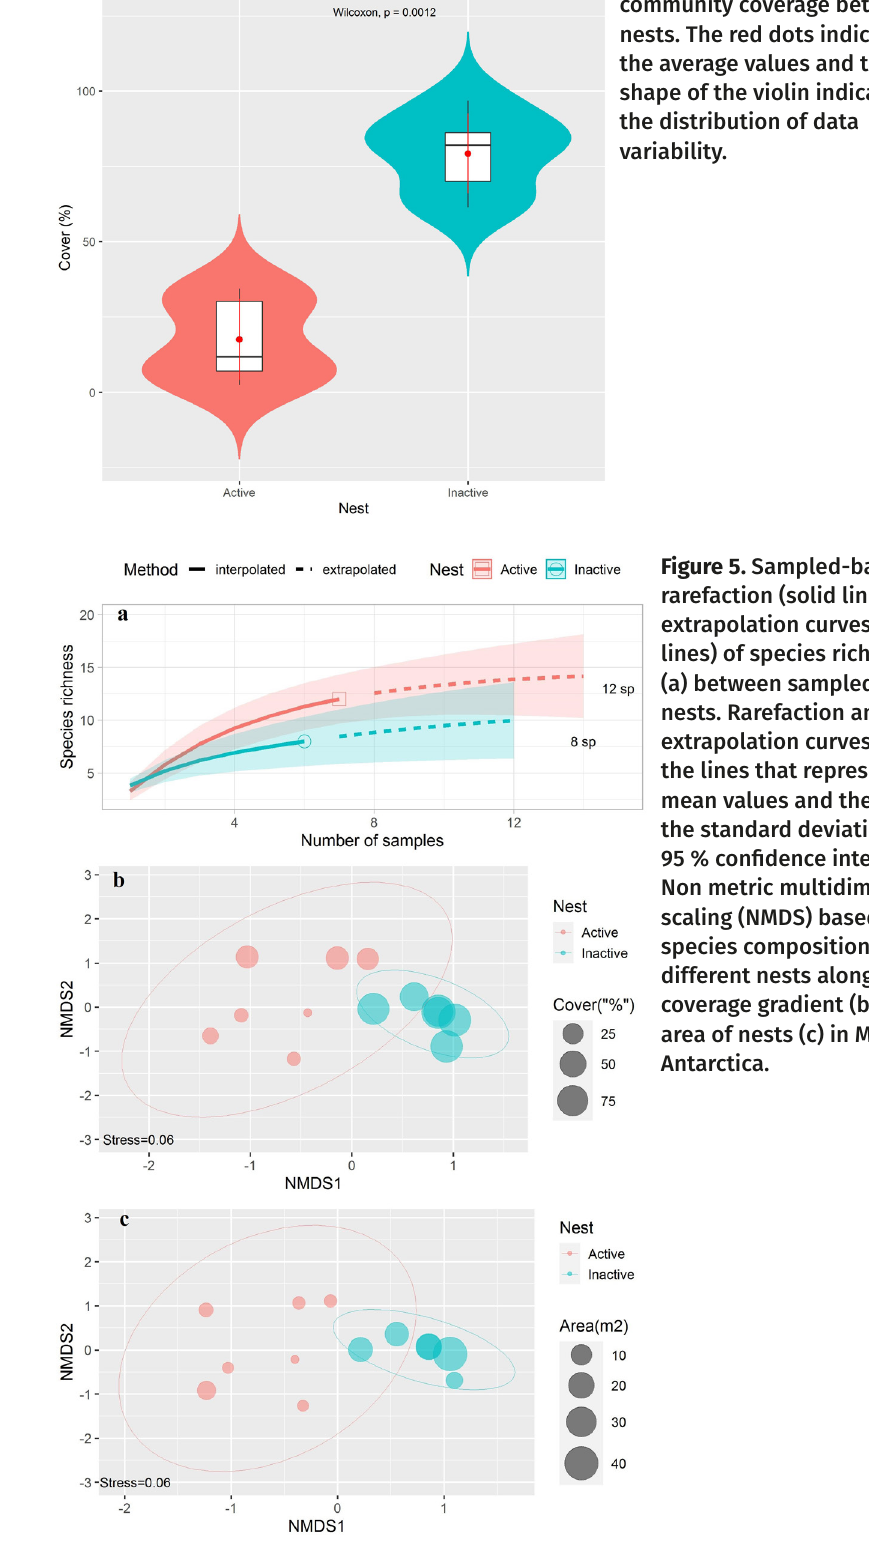
Figure 4. Differences in community coverage between nests. The red dots indicate the average values and the shape of the violin indicates the distribution of data